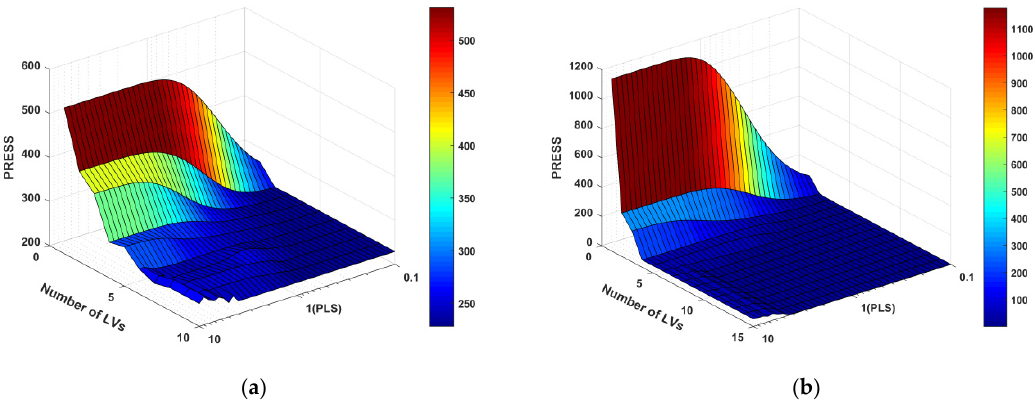
Figure 7. Continuum regression (CR) prediction error surfaces based on the ( a ) electronic nose data and ( b ) NIRS data.